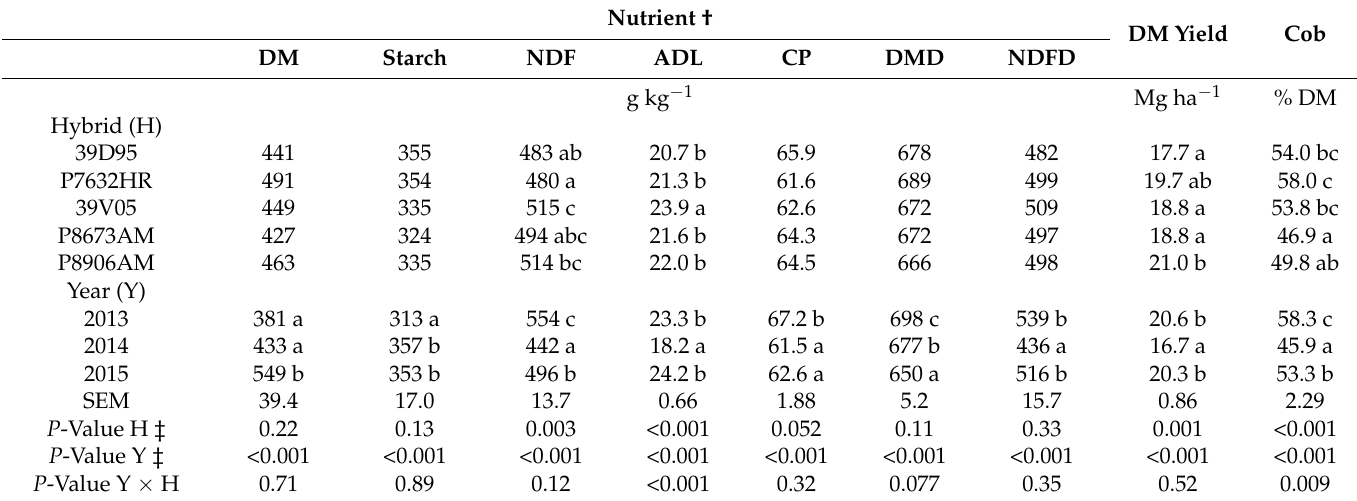
Table 8. Concentration of DM, starch, NDF, ADL, CP, DMD, NDFD, DM yield, and cob percentage for whole-plant corn grown at Elm Creek (Manitoba) over three